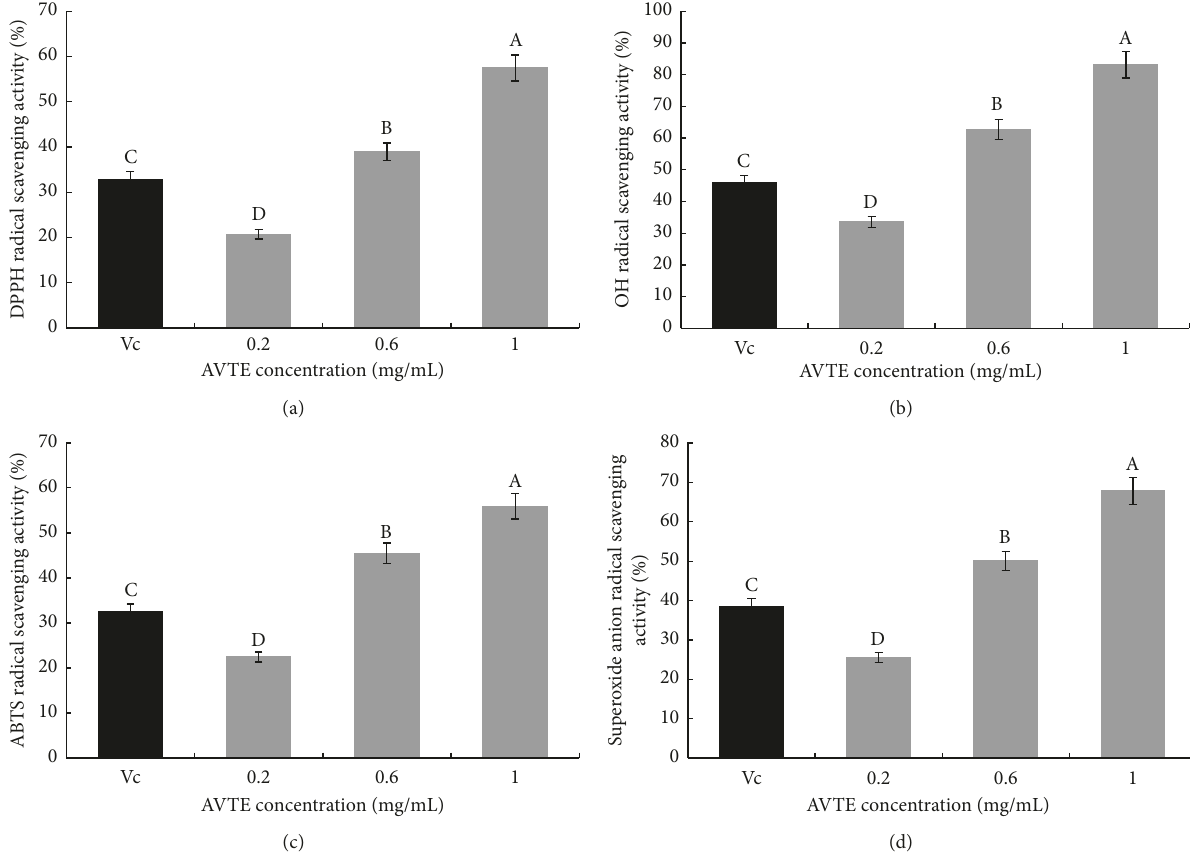
Figure 2: Scavenging activity of AVTE toward 1,1-diphenyl-2-picrylhydrazyl radical (DPPH), hydroxyl radicals (OH), 2,2 ′ -azino-bis (3- ethylbenzthiazoline-6-sulphonic acid) diammonium salt radicals (ABTS), and superoxide anion. (a) DPPH radical; (b) OH radical; (c) ABTS radical; and (d) superoxide anion radical. Ascorbic acid was used as positive control in antioxidant experiments. a–d Mean values with different letters in the same bar graph are significantly different ( P < 0 . 05) according to Duncan’s multiple range